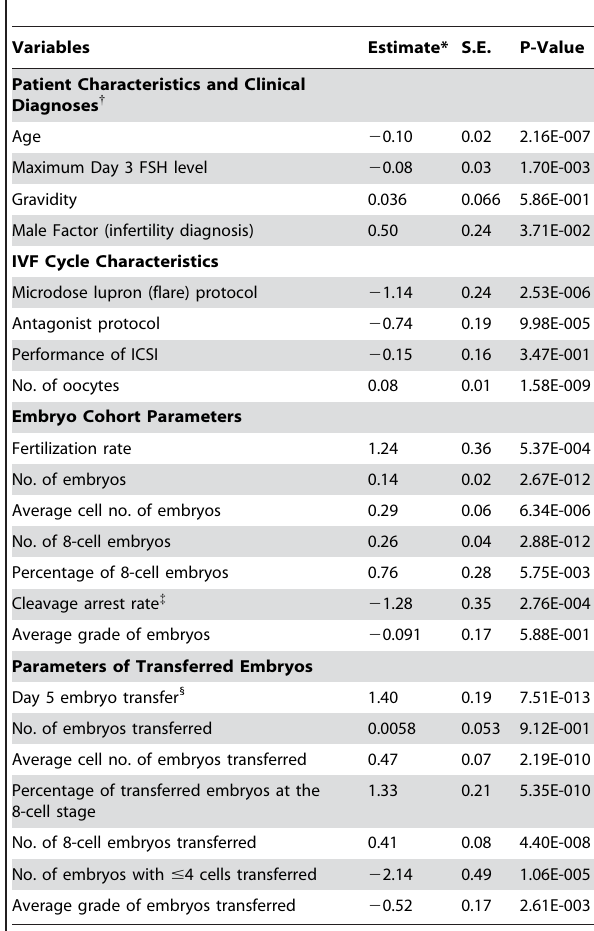
* Positive and negative estimates indicate association with positive and negative pregnancy outcomes,